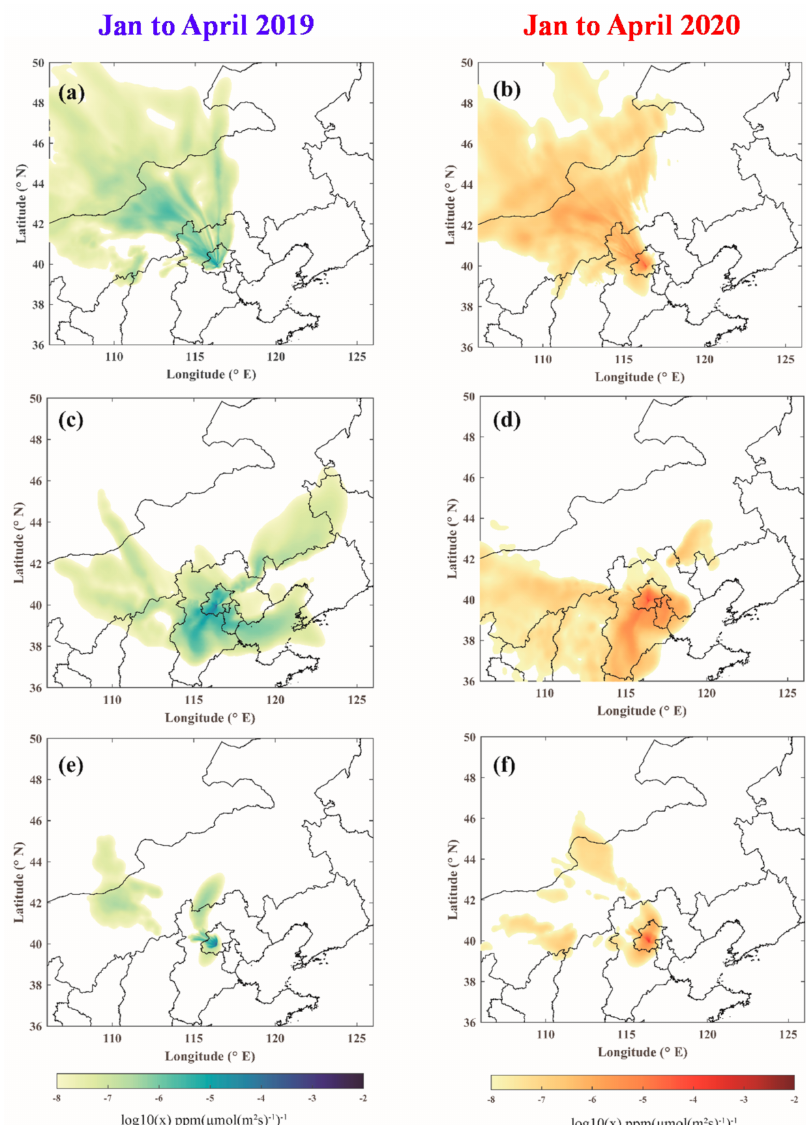
Figure 6. Maps of the average 24 h backward footprint (ppm ( µ mol (m 2 s) − 1 ) − 1 ), log10 (x)) at the Institute of Physics, Beijing, starting at 12:00 local time in different upwind sources from January to April 2019 (blue) and 2020 (red). ( a , b ): The area to the northwest of the observation site is defined as the northwest source (NW source), ( c , d ): the areas to the south and northwest are defined as the north China plain source (NCP source). ( e , f ): stable weather conditions are classified as the locally confined source (LC